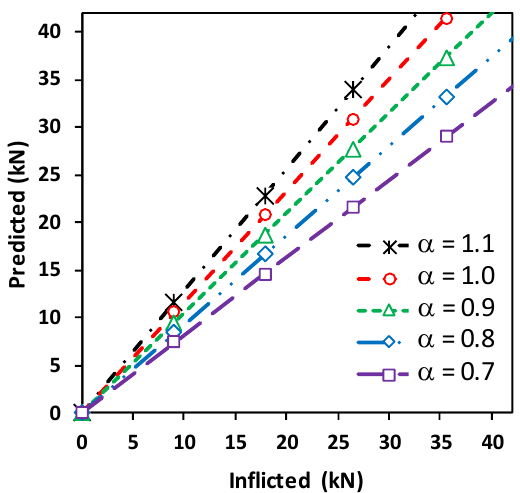
Figure 13. Prediction of tension force changes in axial cylindrical member: load transfer capability factor α = 0.7–1.1.